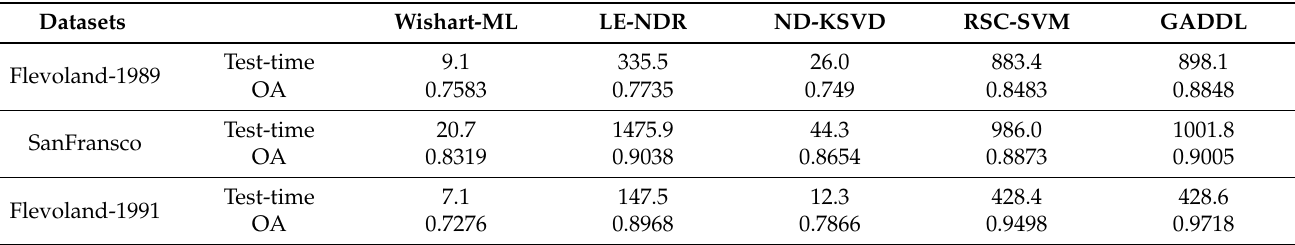
Table 4. The test time (minutes) of different methods on three datasets.